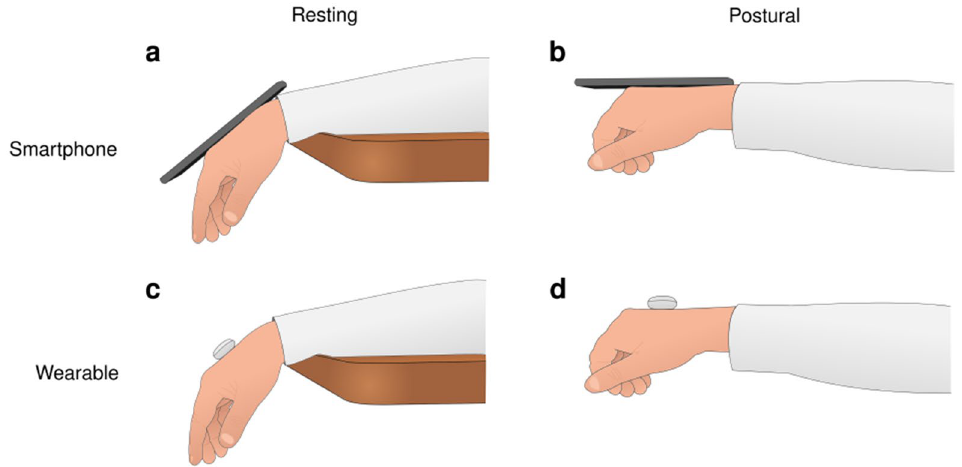
Figure 1. Positioning of the portable devices (lightweight wearable and smartphone) for hand tremor in resting and postural conditions. ( a ) Resting condition and smartphone. ( b ) Postural condition and smartphone. ( c ) Resting condition and lightweight wearable. ( d ) Postural condition and lightweight wearable. The devices were fixed to the hand by a double-sided